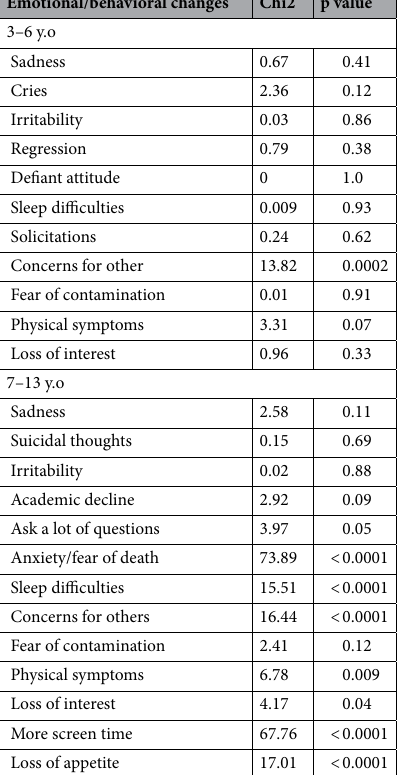
Table 2. Mc Nemar discordance test for emotional/behavioral changes.